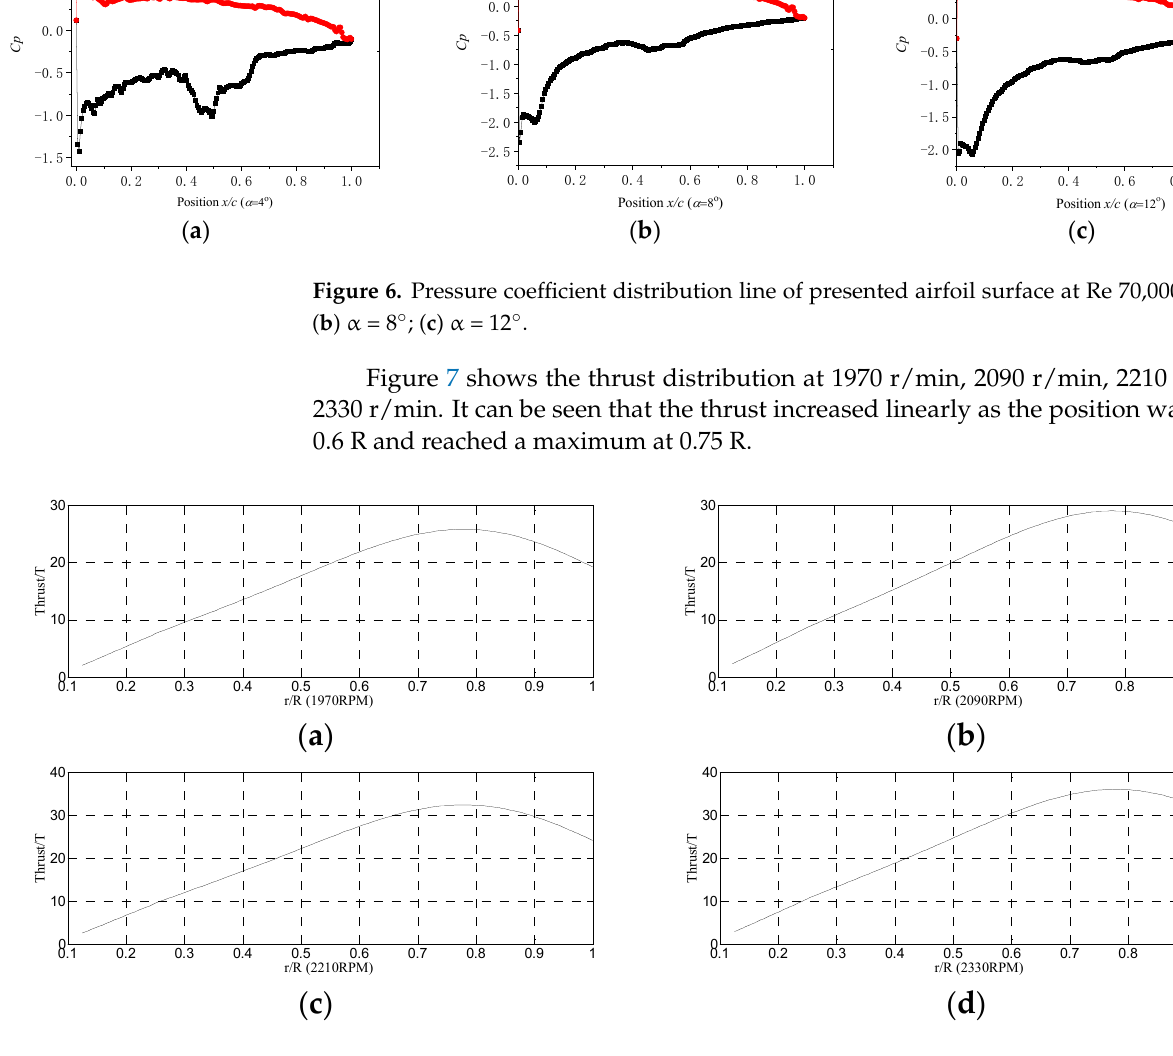
Figure 7. The thrust distribution at ( a ) 1970 r/min, ( b ) 2090 r/min, ( c ) 2210 r/min and ( d ) 2330 r/min. The momentum theory gives the induced power consumption of an ideal hovering (cid:2871)/(cid:2870) /√2. (cid:3404) 𝐶 rotor, i.e., 𝐶 A real rotor generates power consumption from other sources (cid:2926)(cid:3036) (cid:3021) as well, in particular the profile power loss due to the drag of the blades in a viscous fluid. In addition, there is power consumption due to uniformity in the inflow, swirl in the wake and swirl in the tip. Compared with the experimental data, these power losses were relatively small. As shown in Figure 8, the induced power loss had a percentage of 67.5% of the total power losses, and the profile power loss had a percentage of 32.5%. Figure 8. Power consumption. 5. Simulations In this section, numerical simulations for the novel thin circular ‐ arc airfoil with a convex structure were carried out to visualize the results. The flow domain was fully structured and consisted of 100,000 quadrilateral cells, as presented in Figure 9a. The mesh became denser around the airfoil and at the leading and trailing edges, as shown in Figure 9b. ( a ) ( b ) Figure 9. Mesh distribution. ( a ) Mesh domain; ( b ) mesh on the leading edge of airfoil.